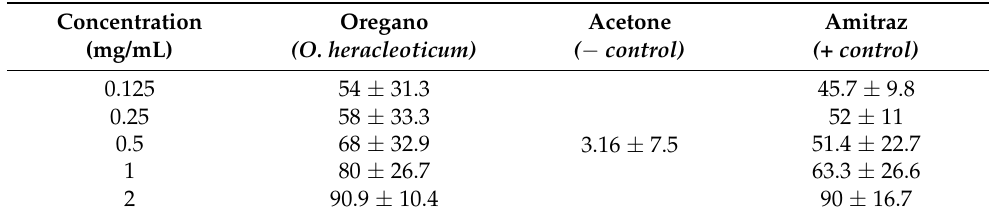
Table 2. V. destructor neutralized percentage and SD ( ± ) after the treatment with O. heracleoticum essential oil, acetone and